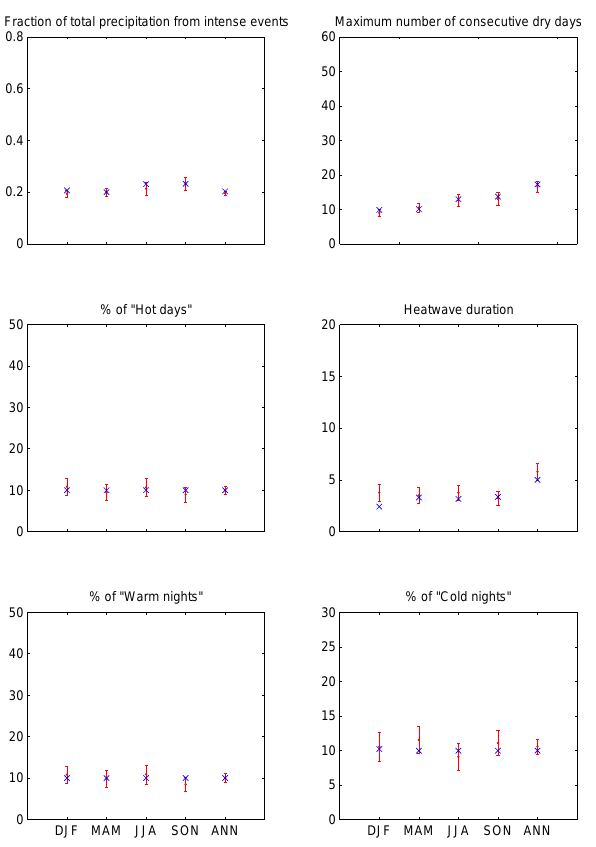
Fig. 3a. RCM 2080s scenario (HadRM3Q0 – blue, shown as crosses) and simulated (dots and error bars) averages for each half month for the grid cell nearest Heathrow based on a 30yr period (1961–1990). The simulated values are the means of 100 weather generator runs. The lines and bars show the variability of the 100 runs (plotted as plus/minus two standard deviations around the